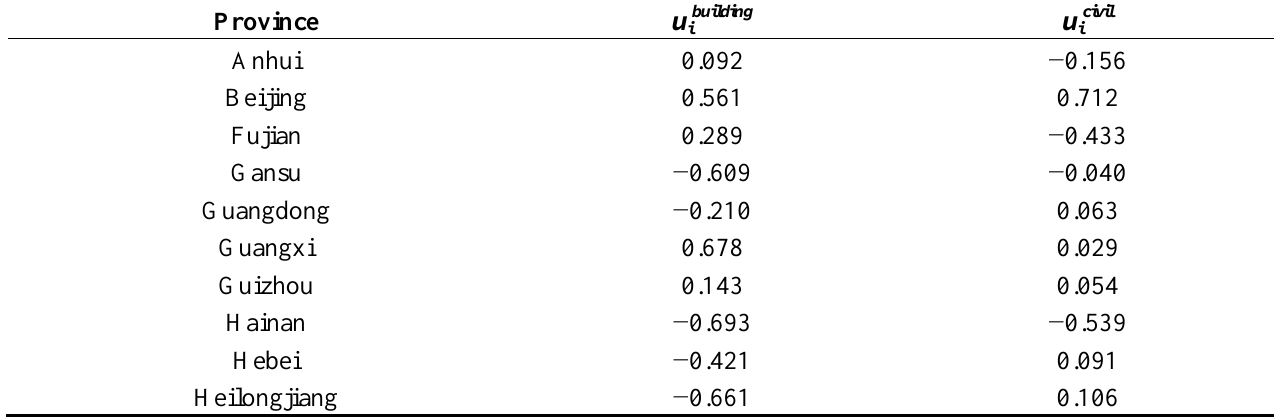
Table A1. The random-error components u ibuilding and u icivil for each